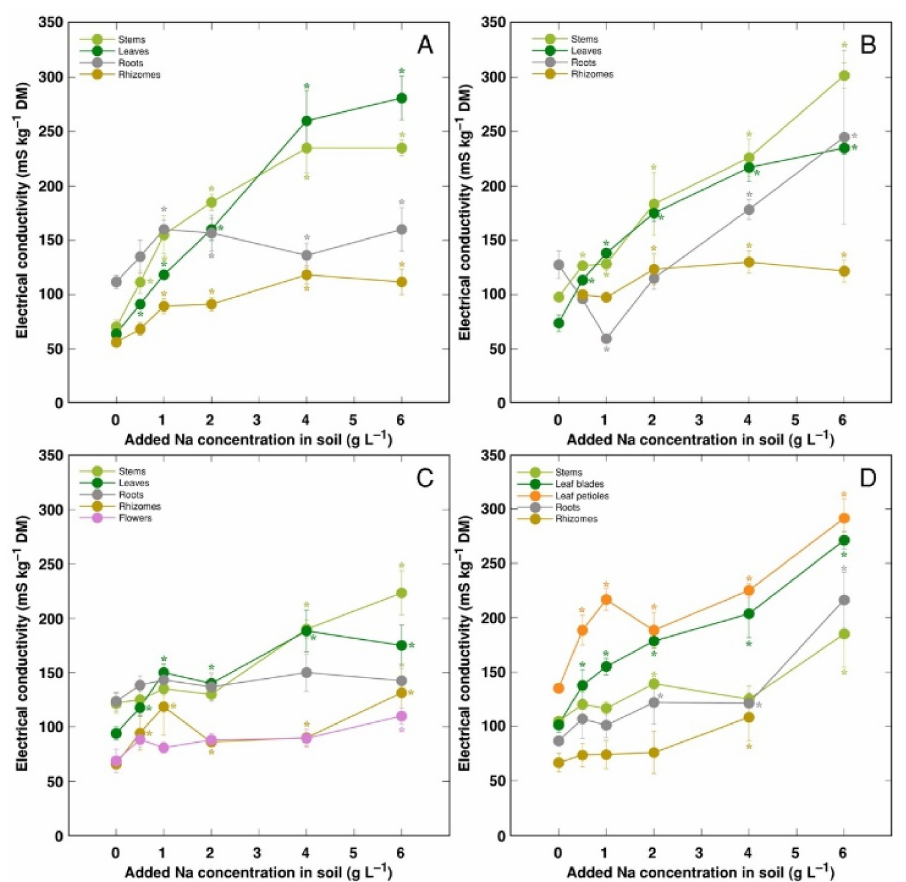
Figure 8. Changes in electrical conductivity under the effect of increasing soil salinity in different parts of Calystegia sepium accessions CSe1 ( A ), CSe2 ( B ), CSe3 ( C ) and Calystegia soldanella ( D ). Na + was added in a form of NaCl. Data are means from three replicates for each concentration ± SE. Asterisks of the respective color indicate statistically significant differences ( p < 0.05) from control. The trend of changes in the total osmotic value was similar to that for electrical conductivity; however, differences between plant organs were less pronounced (Figure 9). However, distribution of the osmotic value not associated with Na + , K + and Cl − (non-ionic osmotic value), under the effect of increasing soil salinity, showed both genotype- and organ-specific differences (Figure 10). Concentration of non-ionic osmolytes increased as a result of increased soil salinity in stems, leaves, roots and rhizomes of CSe1 (Figure 10A), stems and leaves of CSe2 (Figure 10B), all plant parts except roots of CSe3 (Figure 10C), and in leaf petioles of CSo, with a significant increase in all plant parts at the highest salinity (Figure